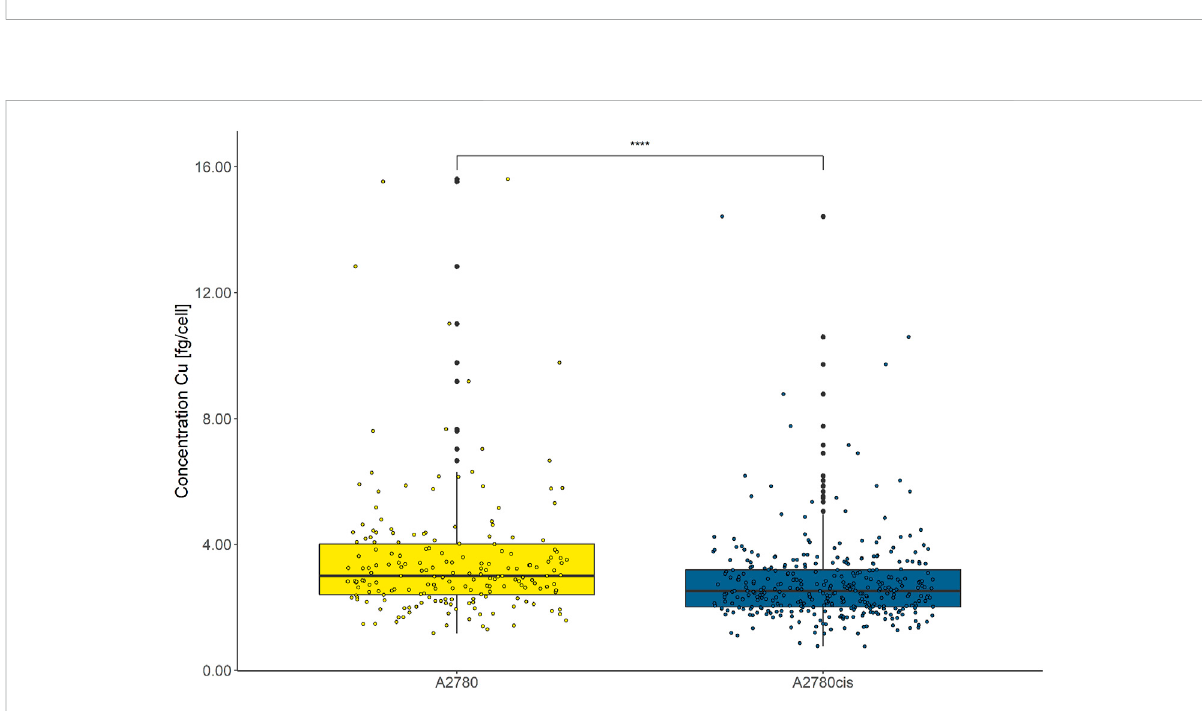
FIGURE 7 BoxplotsshowingtheconcentrationofintracellularCucell − 1 ofA2780andA2780ciscells.CytospinsamplesweremeasuredbyLA-ICP-TOFMS at the single-cell level. All values below the LOD were removed. A Wilcoxon test was performed for the statistical comparison of the different cell types. Signi fi cance codes: (*) p ≤ 0.05, (**) p ≤ 0.01, (***) p ≤ 0.001, (****) p ≤